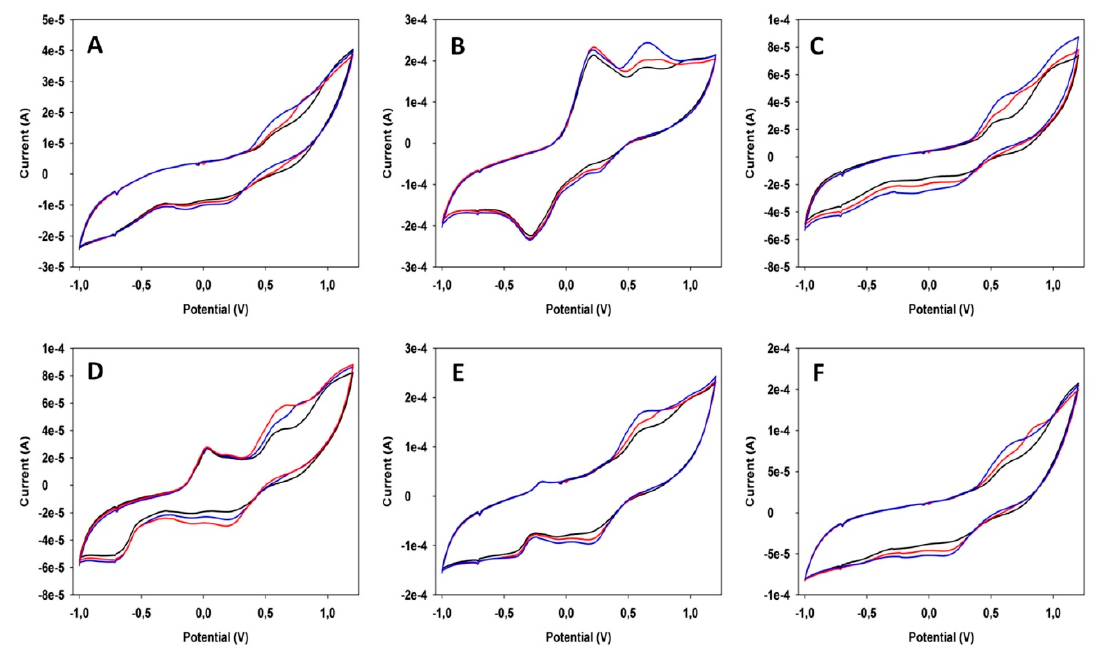
13 of 19 ratio (132 numbers per sample) to keep the maximum information with the minimum data size. Then, an ANN model was built with 27 standards containing different proportions of the three analytes (according to a 3 3 factorial design). The model is composed by neurons, i.e., calculation units organized in layers (usually three) which use transfer functions that operate the numbers in the preceding layer to generate the numbers in the next layer. A critical point in ANN strategy is to design the architecture of the network (e.g., the neurons per layer or the type of transfer functions). In this case, a network was built with 132 neurons in the input layer, 3 neurons in the hidden layer and 3 neurons in the output layer. The training of the ANN consists on the optimization of the coefficients